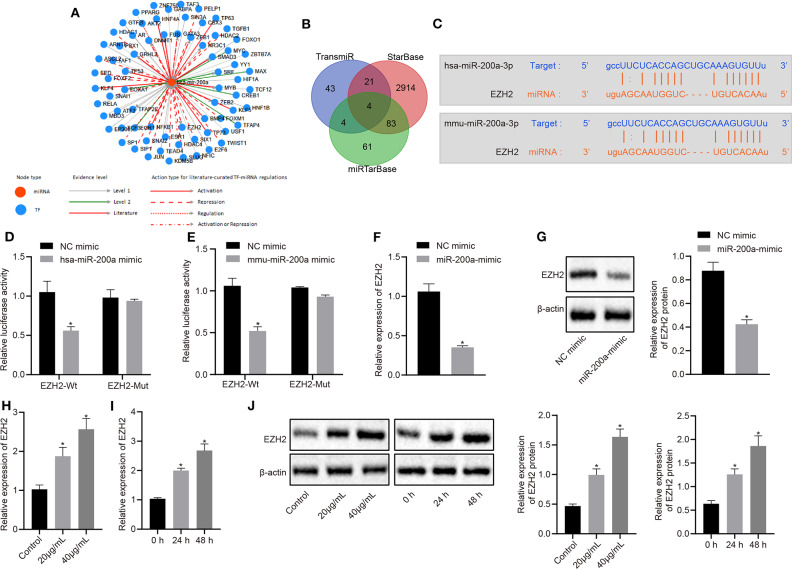
miR-200a targets EZH2 and downregulates EZH2 in HUVECs. (A) The interacting transcription factors that interacted with miR-200a predicted using TransmiR database (http://www.cuilab.cn/transmir). (B) Venn graph (http://bioinformatics.psb.ugent.be/webtools/Venn/) of intersection of prediction results of TransmiR with StarBase database (http://starbase.sysu.edu.cn/) and miRTarase database (http://mirtarbase.mbc.nctu.edu.tw/php/index.php). (C) Binding site of miR-200a EZH2 3′-UTR. (D) Target relationship between miR-200a and EZH2 in HUVECs detected using dual-luciferase reporter gene assay. (E) Target relationship between miR-200a and EZH2 in arterial tissues of ApoE−/− mice detected using dual-luciferase reporter gene assay. HUVECs were treated with exogenous miR-200a mimic (with NC mimic as control). (F) EZH2 mRNA level in HUVECs determined by RT-qPCR, normalized to GAPDH. (G) EZH2 protein level in HUVECs determined by Western blot analysis, normalized to β-actin. HUVECs were treated with 0, 20, and 40 μg/ml ox-LDL for 24 h. (H) EZH2 mRNA level in HUVECs determined by RT-qPCR. HUVECs were treated with 0, 20, and 40 μg/ml ox-LDL for 24 h. (I) EZH2 mRNA level in HUVECs treated with 20 μg/ml ox-LDL for 0, 24, and 48 h determined by RT-qPCR. (J) EZH2 protein level in HUVECs determined by Western blot analysis, normalized to β-actin. HUVECs were treated with 0, 20, and 40 μg/ml ox-LDL for 24 h as well as treated with 20 μg/ml ox-LDL for 0, 24, and 48 h.*indicates p < 0.05 compared with untreated HUVECs or empty vector-treated HUVECs. Unpaired t-test was used to compare data from two groups and one-way ANOVA/Tukey's post-hoc test to compare data from multiple groups.